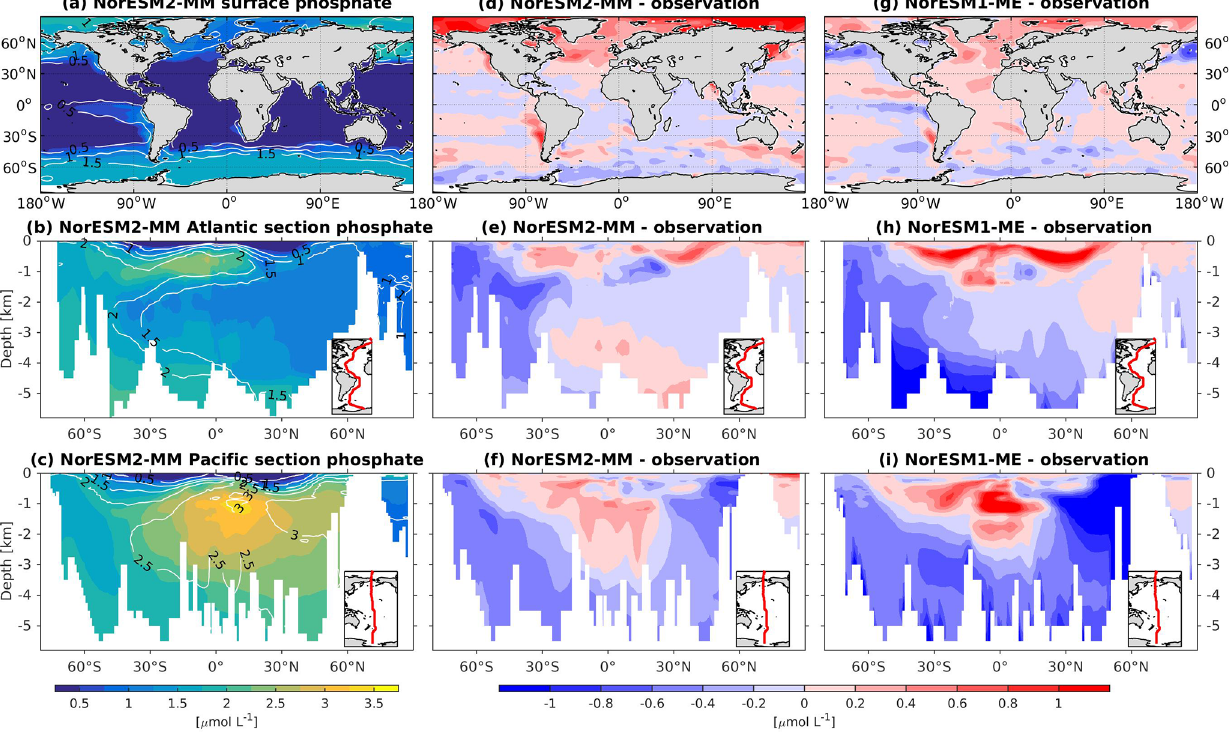
Figure 7. Climatological phosphate values at the (a) surface and across the vertical sections of (b) the Atlantic and (c) Pacific in NorESM2- MM (colour shadings) and from observations (contour lines). Differences between NorESM2-MM (or NorESM1-ME) and observations are shown in panels (d) – (i)